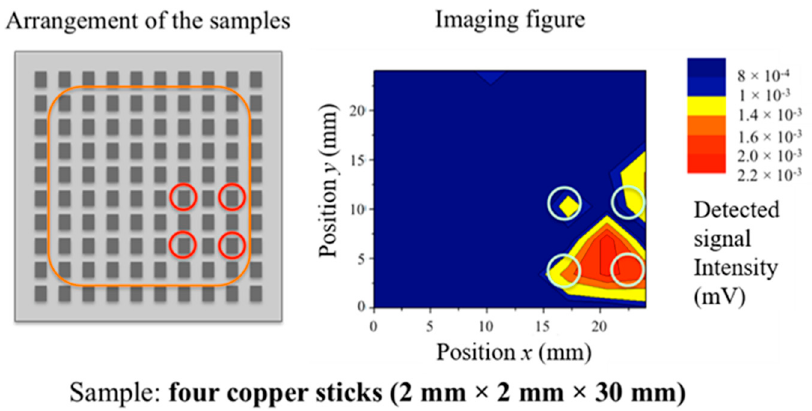
Figure 15. Two-dimensional imaging of conductive samples (four copper sticks).